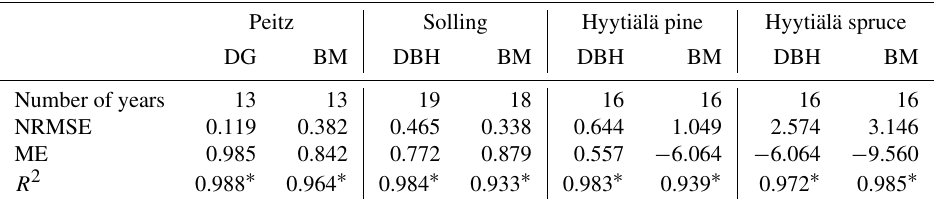
Table 3. Statistics for the three sites (DG – geometric mean diameter, DBH – diameter at breast height, BM – stem biomass, number – number of